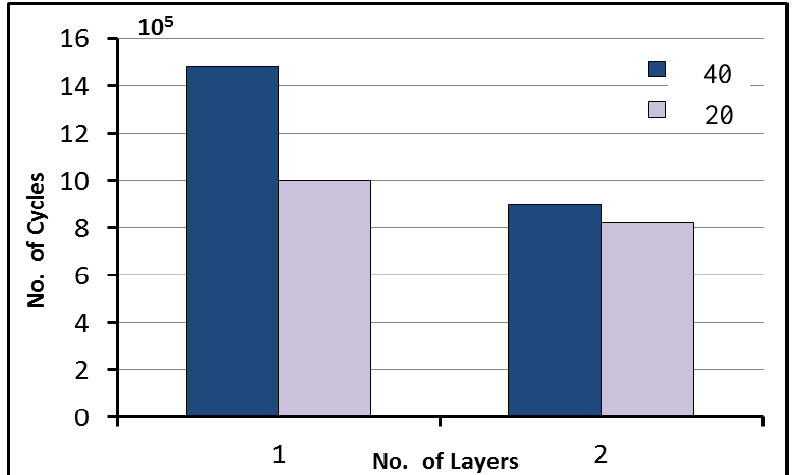
Fig.4: The relation between fatigue cycle and number of layer for random glass fiber at volume fractions 20% and